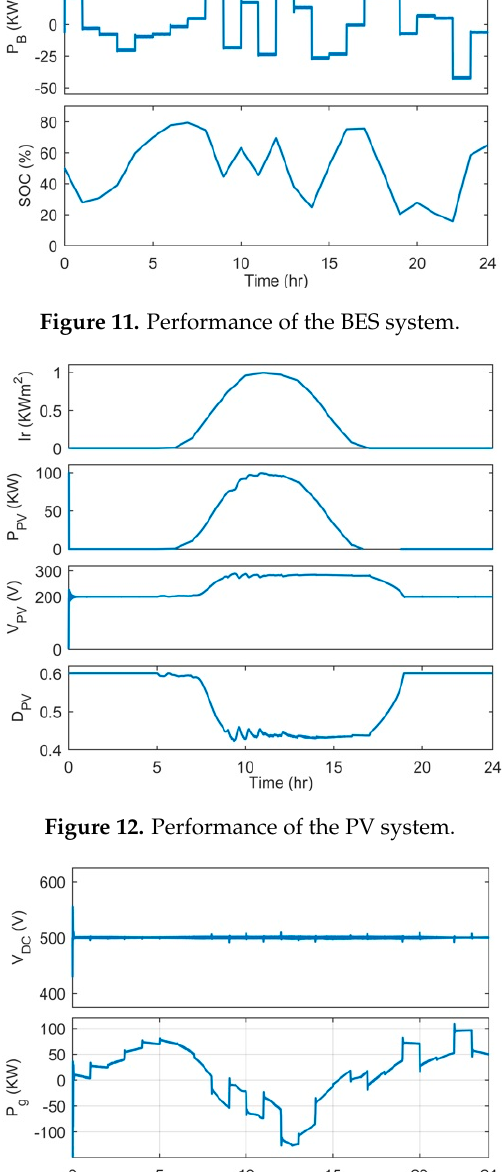
Figure 13. Performance of the voltage source converter (VSC).